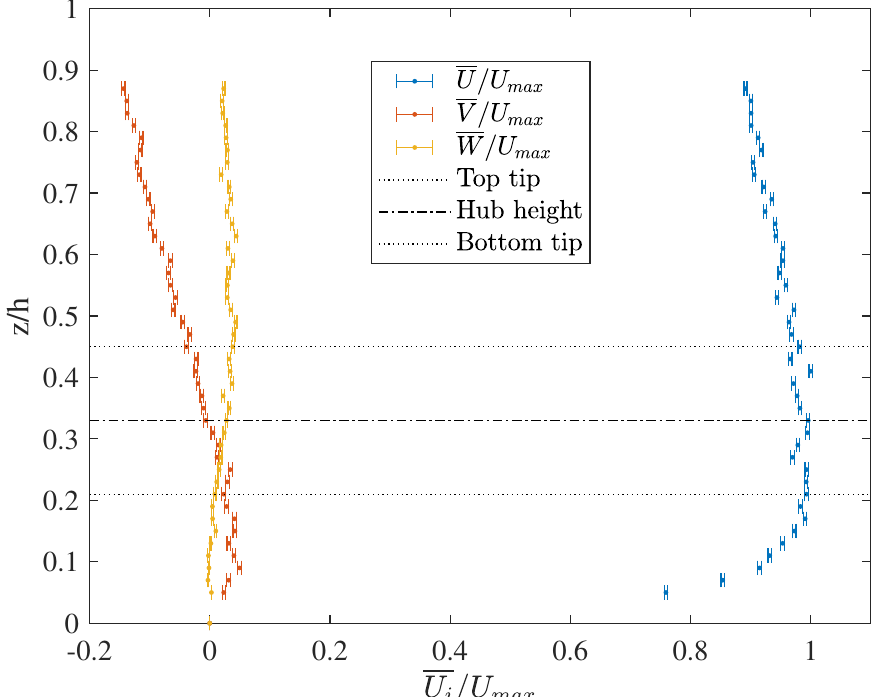
Figure 2. The freestream, U , V , and W mean velocity profiles measured by ADV. Error bars indicate the 95% confidence interval (see Section 2.6).